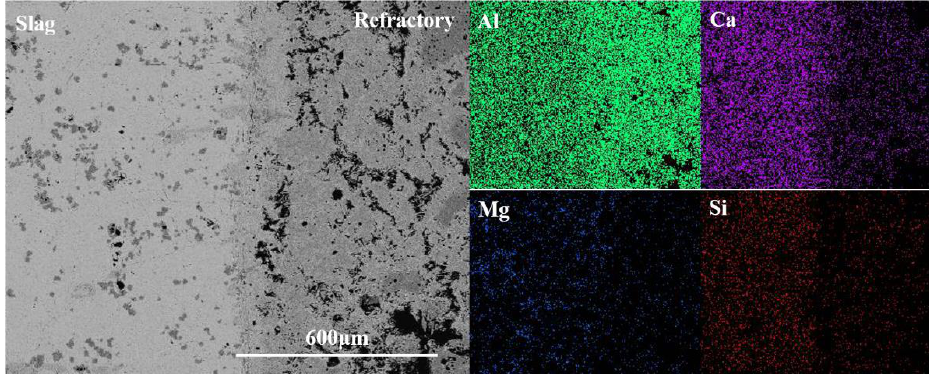
Figure 6. Element mapping of the slag-crucible interface of Al 2 O 3 crucible.